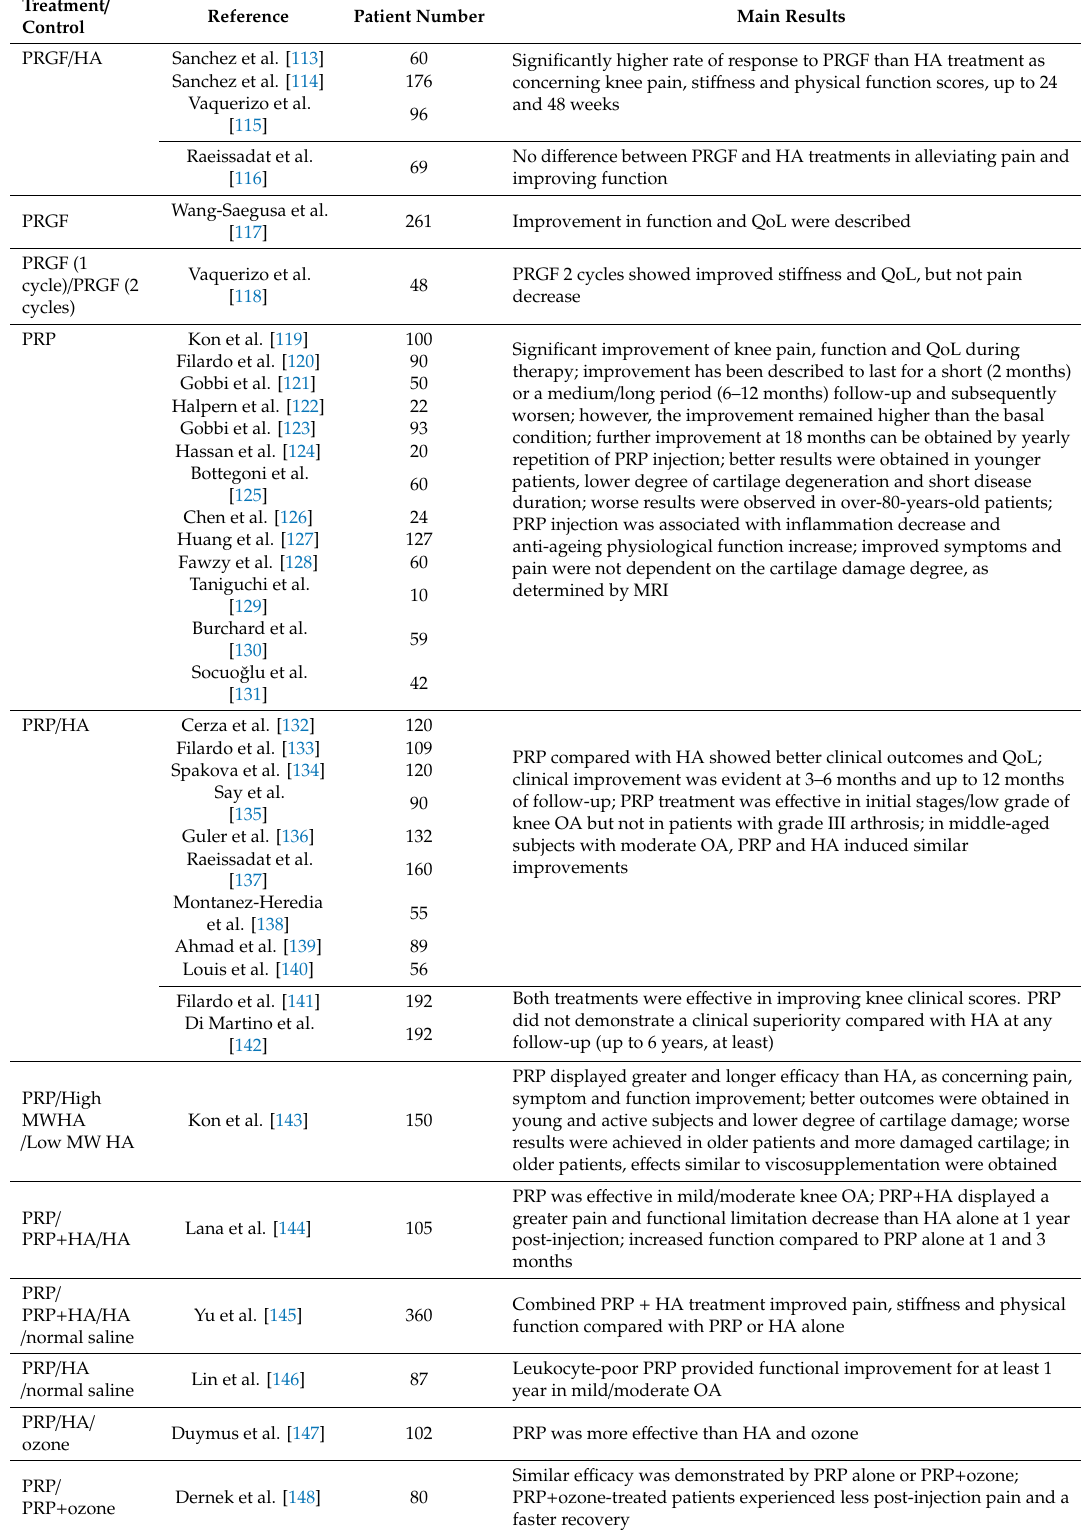
Table 3. Evidence of PRP treatment in knee OA (reported by year of study and grouped by treatment). Treatment /